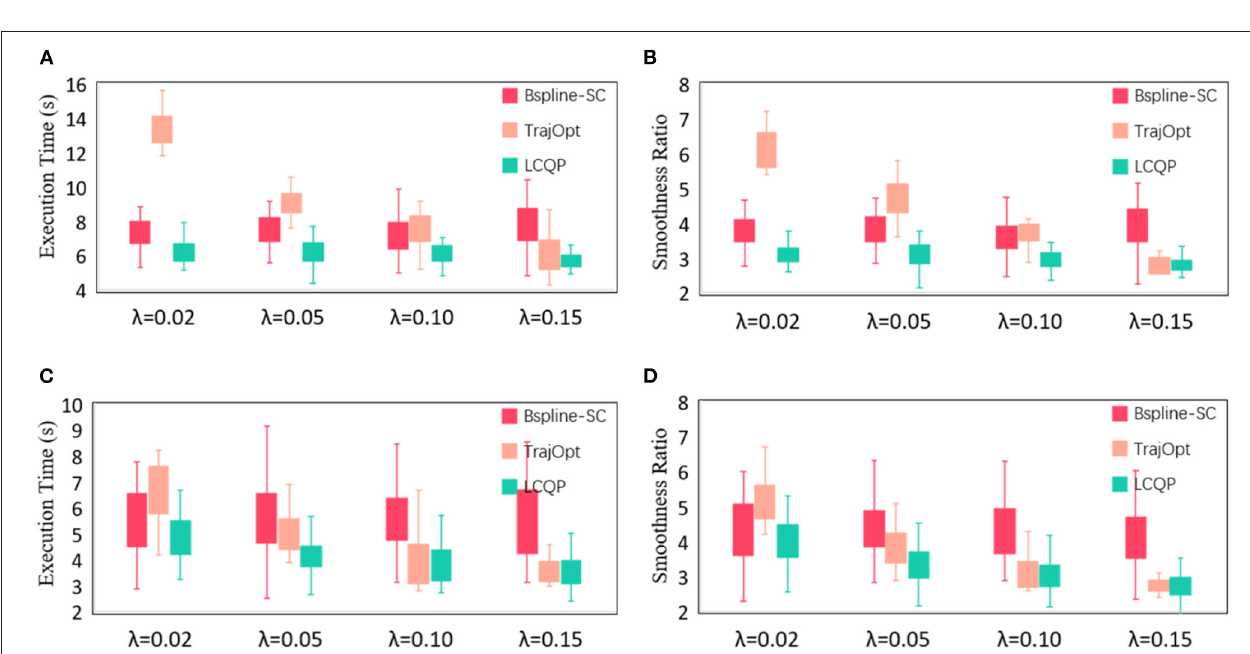
FIGURE 7 | (A) Execution time of maze-like map; (B) Smoothness ratio of maze-like map; (C) Execution time of randomly-generated obstacles map; (D) Smoothness ratio of randomly-generated obstacles map. The quantitative evaluation results of three post-trajectory methods in 2D experiments.